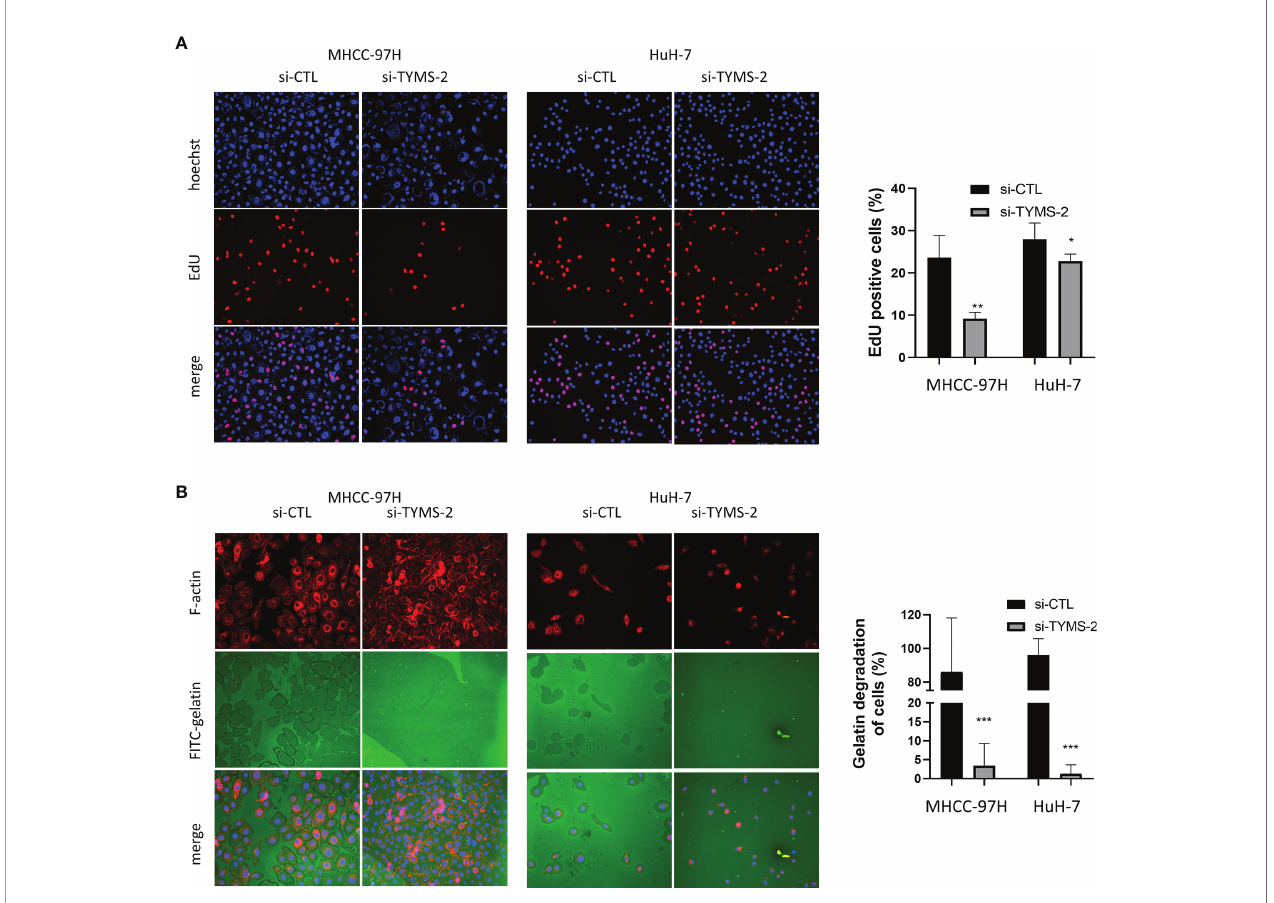
FIGURE 7 | TYMS plays a role in HCC cell ’ s DNA synthesis and invasiveness. (A) The EdU incorporation analyses the effects of TYMS on cell proliferation. (B) TYMS is necessary for ECM degradation in MHCC-97H and HuH-7 cells. Cells were plated on coverslips coated with FITC- gelatin (green) for 8 h, F-actin was stained with phalloidin (red), and nuclei were stained with DAPI (blue). Gelatin degradation was shown as black areas. *P < 0.05, **P < 0.01, and ***P <